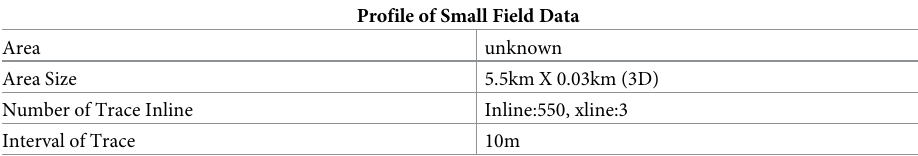
Table 3. Small field data.